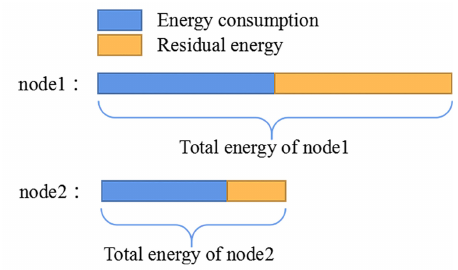
Figure 7. The energy consumption of node2 is less than that of node1. However, node1 consumes only 50% of its total energy while node2 consumes about 80% of the whole energy.